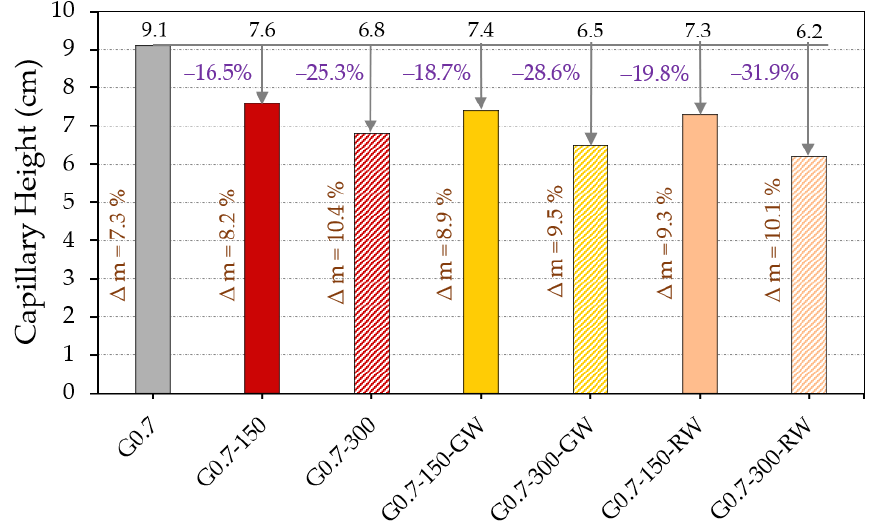
Figure 7. Results of the capillary water absorption test.